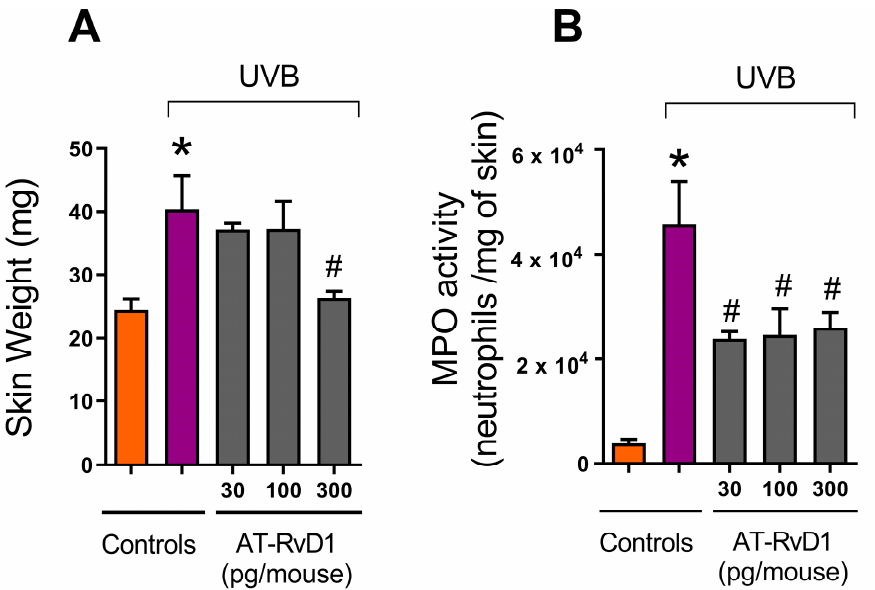
Figure 1. Effect of three doses of AT-RvD1 on edema and neutrophil infiltration in the skin of hairless mice exposed to 4.14 J/cm 2 UVB radiation. Edema ( A ) and neutrophil infiltration (quantitated by the MPO activity) ( B ). Skin samples were collected 12 h after the radiation session. Bars represent means ± SEM. Two separate experiments with five groups of 5 mice per group per experiment were performed. Statistical analysis was performed by one-way ANOVA, followed by Tukey’s post hoc test. * p < 0.05 compared to the nonradiated control group (orange bars); # p < 0.05 compared to the radiated control group (purple bars).